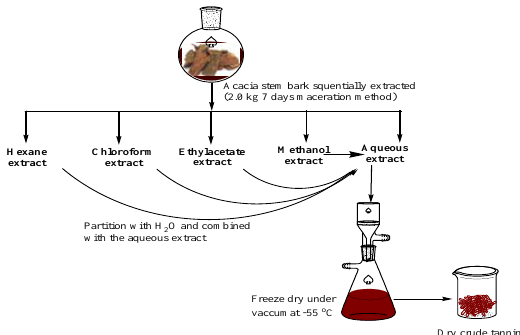
Figure 1. Sequential Extraction of Tannin from the Acacia Stem Bark.